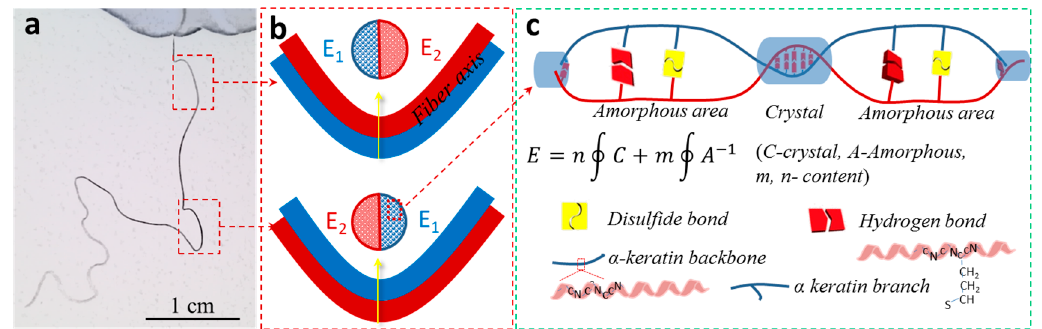
Figure 2. How does the hair crimp? ( a ) A yak hair in free crimped state, ( b ) a crimp made of orthocortex and pi-cortical cells with different modulus E 1 and E 2 along the hair axis, and ( c ) in either cortex made of different contents of crystalline and amorphous phases for the hair crimping.